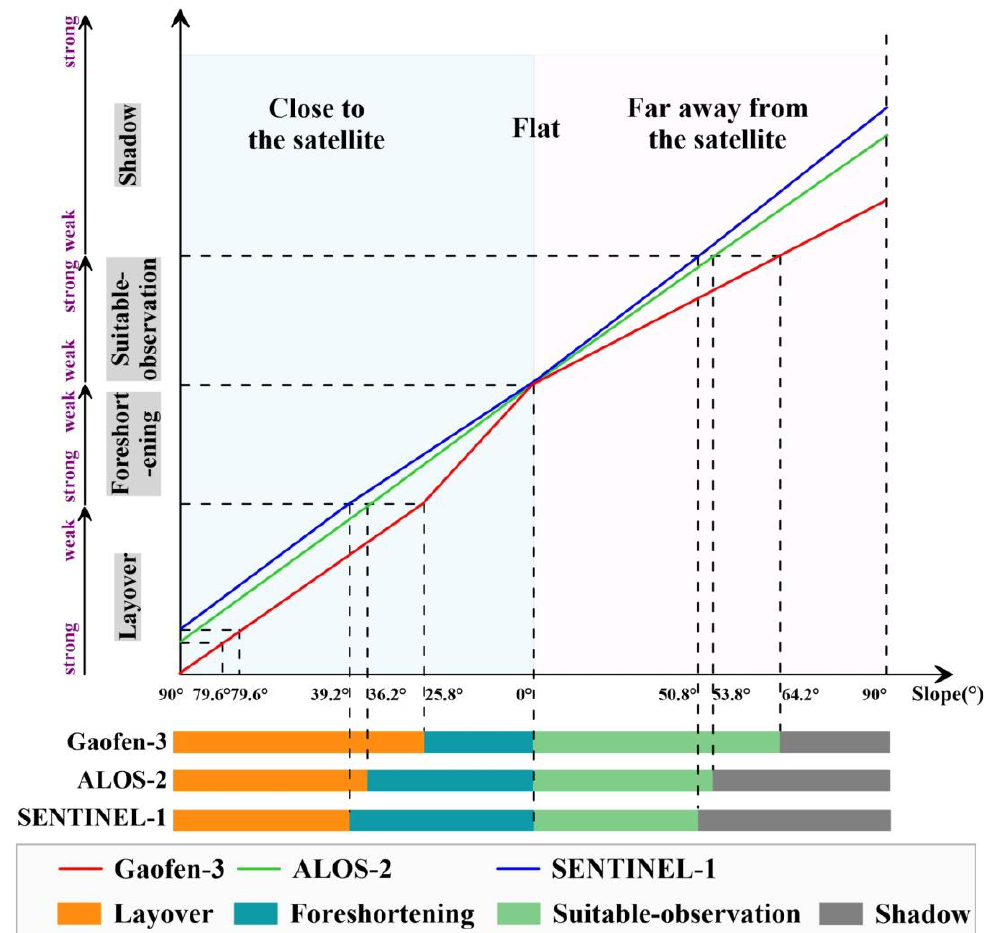
Figure 8. Relationship between the slope angle and geometric distortion of the SAR